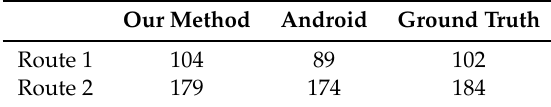
Table 6. Step counts of our PDR algorithm and Android